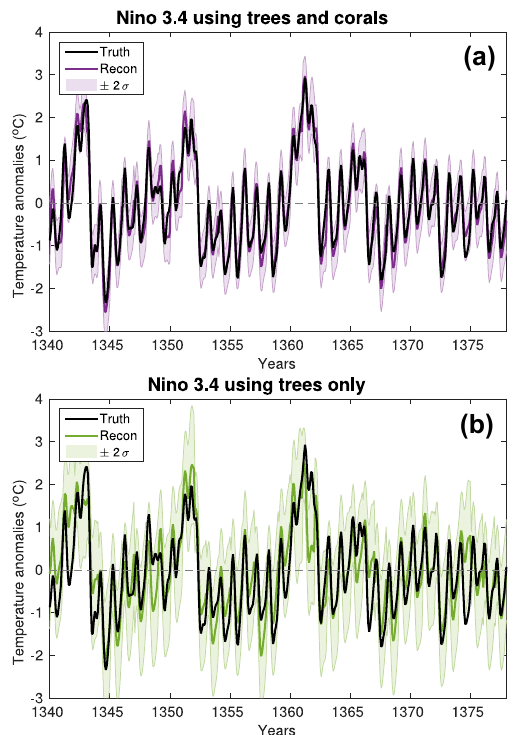
Figure 8. Monthly reconstruction of Nino 3.4 index during the most severe drought period in the reconstruction (a) using both pseudo- trees and pseudo-corals and (b) using only pseudo-trees. The 2 σ uncertainty estimates are derived from both the Monte Carlo recon- struction iterations and the posterior distribution; see Sect. 2.4 for